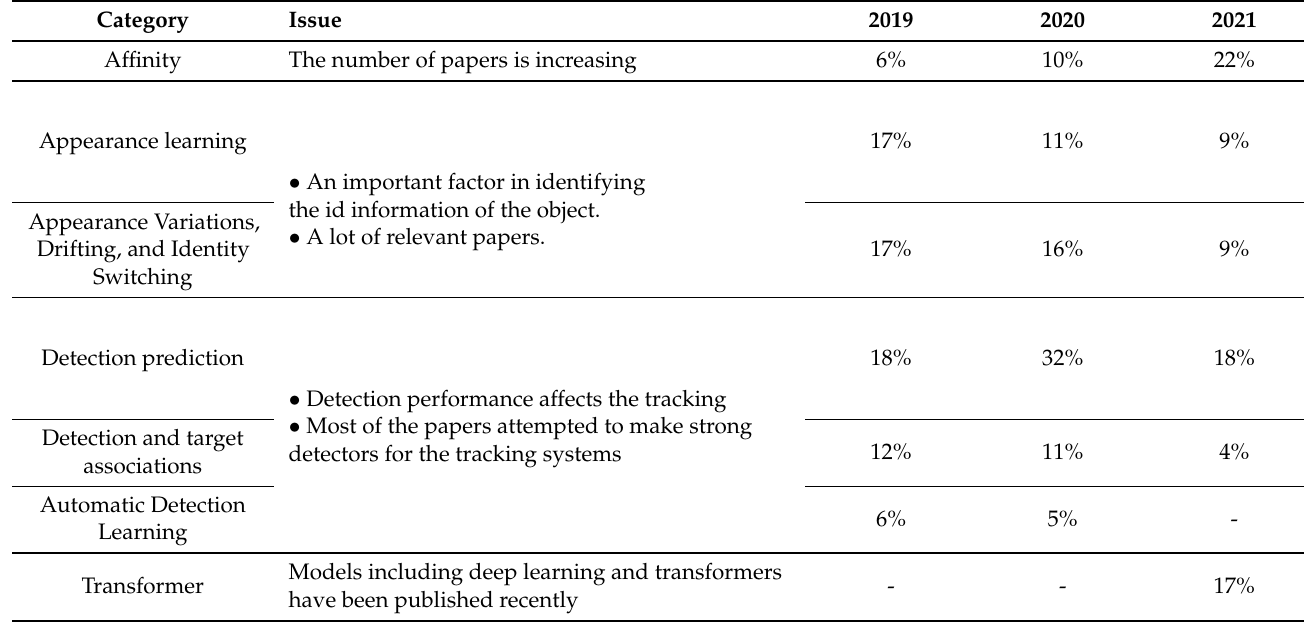
Figure 19. Notable MOT trends from the last three years (2019–2021). Table 4. Organized issues by trends in MOT papers from the past 3